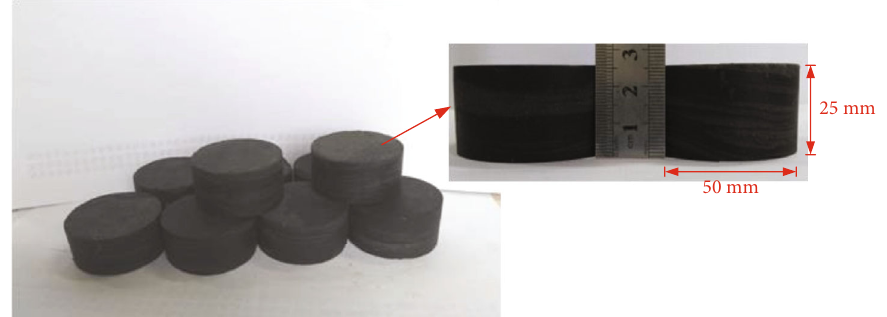
Figure 4: Mudstone specimen: diameter 50 mm and length 25mm.